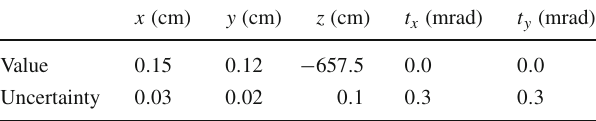
Table 1 Coordinates of the upsteam face of the T2K replica target (in the NA61/SHINE coordinate system, see Fig. 1) and their uncertainty as well as the tilt of the